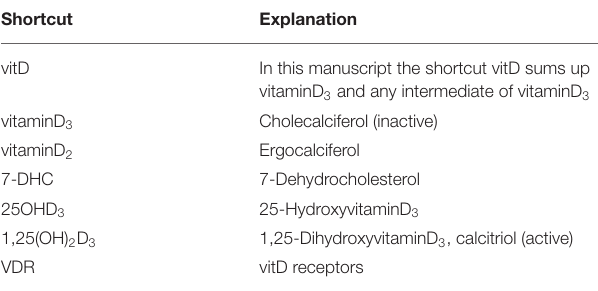
TABLE 1 | Chemical and metabolic background of vitD.